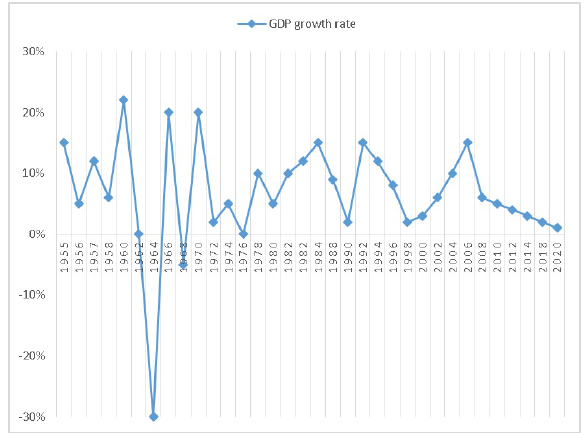
Fig. 3 Evolution trend of production efficiency of